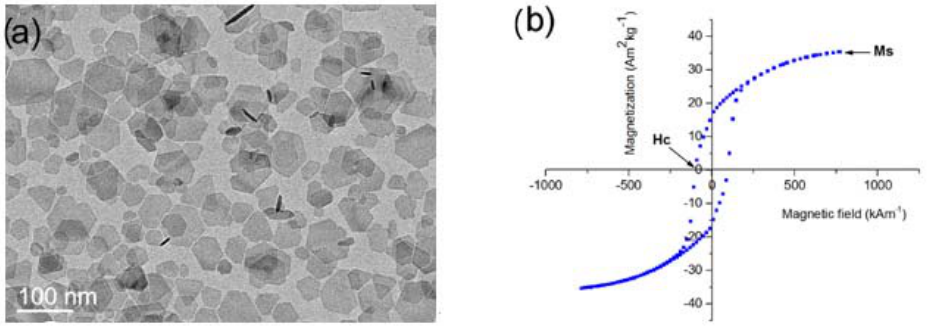
Figure 1. As − synthesized BHSF NPLs: ( a ) TEM image and ( b ) magnetic hysteresis measured at room temperature with saturated magnetization (Ms) and coercivity (Hc).